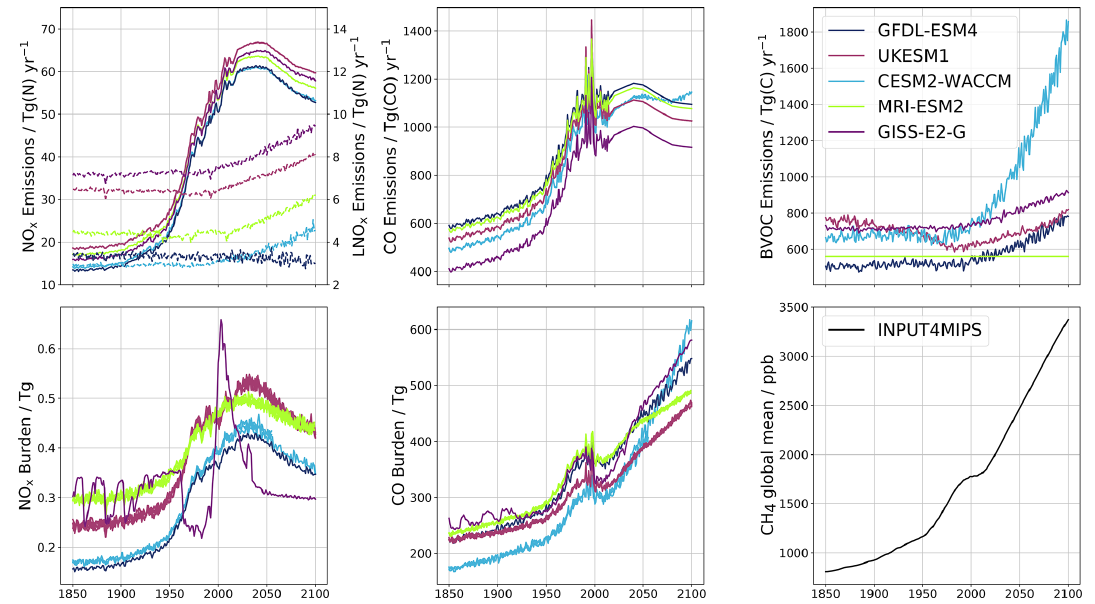
Figure 1. Diagnosed emissions and burden of tropospheric-ozone precursors. Maroon line: UKESM1; light blue line: CESM2-WACCM; dark blue line: GFDL-ESM4; dark red line: GISS-E2-1-G; green line: MRI-ESM2-0.